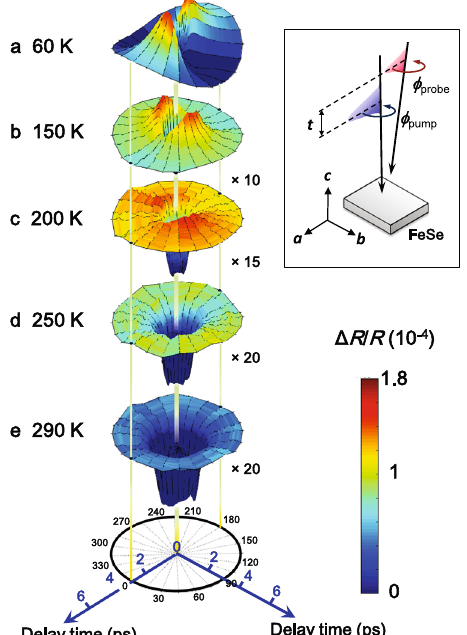
Fig. 1 Three-dimensional plot of orientation-dependent photoin- duced re fl ectivity ( Δ R / R ) transients at various temperatures. Inset : schematics of the experimental setup of polarization-dependent pump – probe spectroscopy. ϕ pump = 0° and ϕ probe = 0° indicate that the E fi eld of pump and probe pulses along a -axis of an FeSe single crystal